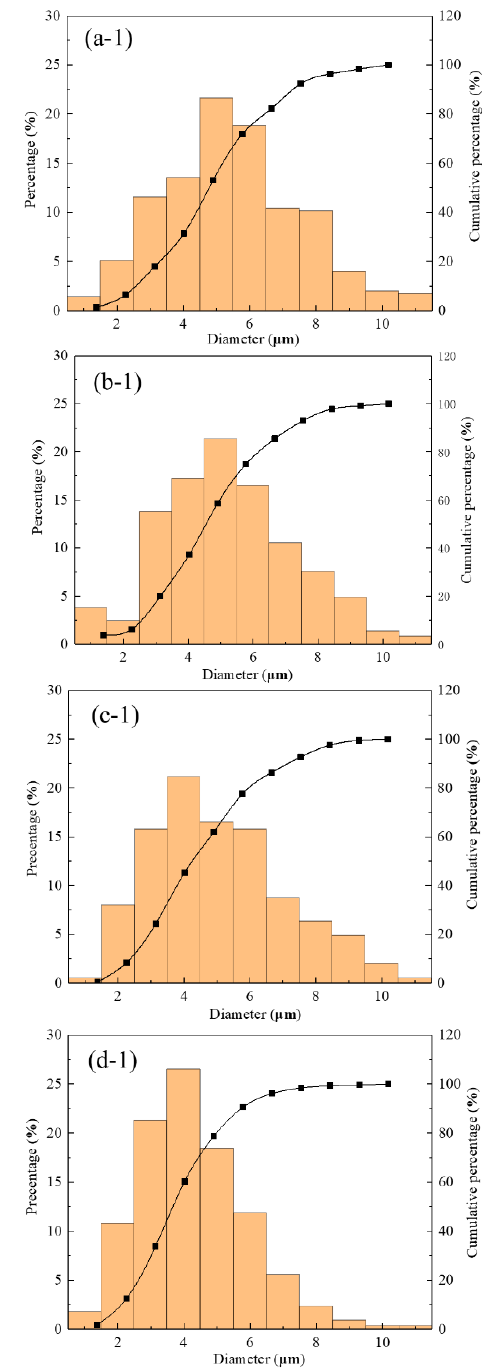
6 of 11 Figure 5. Metallographic structure processing for OABs: ( a ) primary m etallographic structure; ( b ) after the grains were resolved more sharply; ( c ) final metallographic structure.